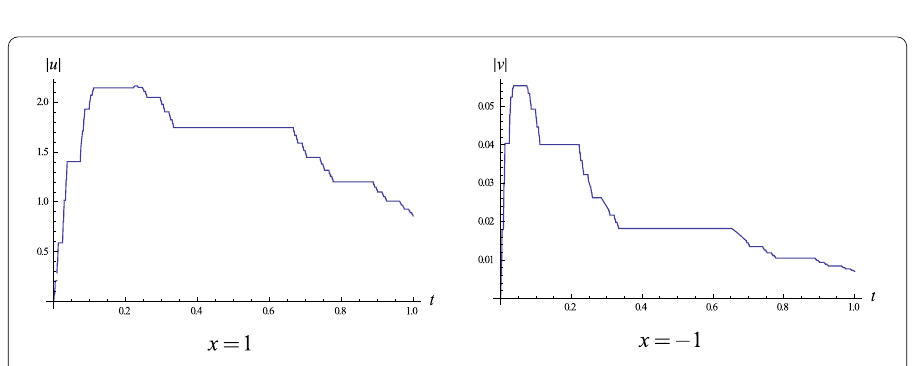
Figure 11 Profiles along the t axis of one-fractal solutions (206) and (207) with α = ln2/ln3.